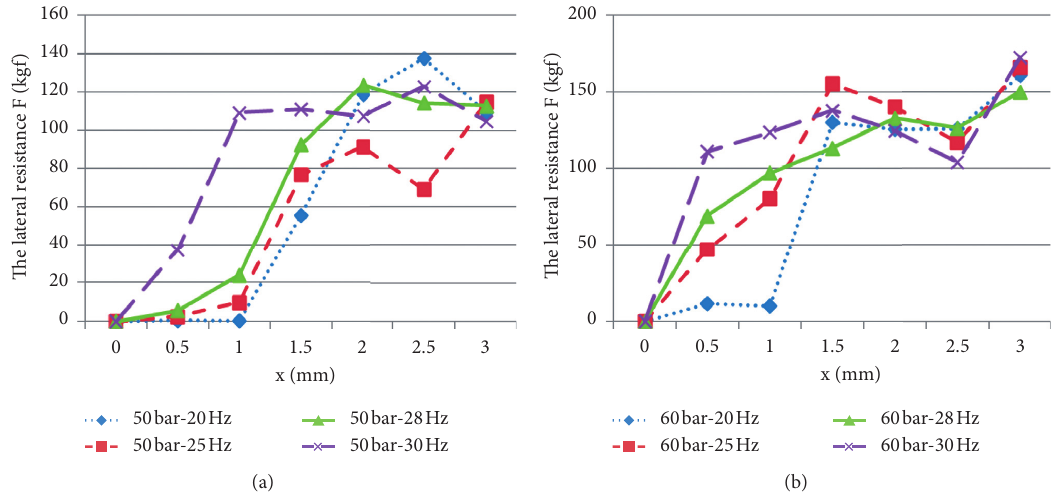
Figure 15: The curve of the lateral resistance under different frequencies and fixed